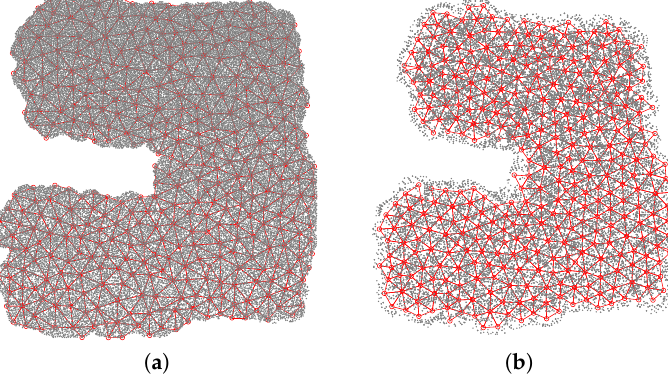
Figure 7. Network with non-uniform node distribution: ( a ) The original network with non-uniform node distribution. The nodal degrees range from 11.3–18.7. ( b ) The localization result of our algorithm with the localization error